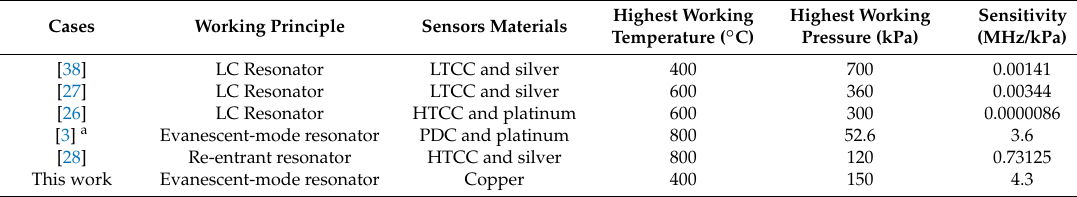
Table 1. Characteristics of different pressure sensors for harsh-environment applications.